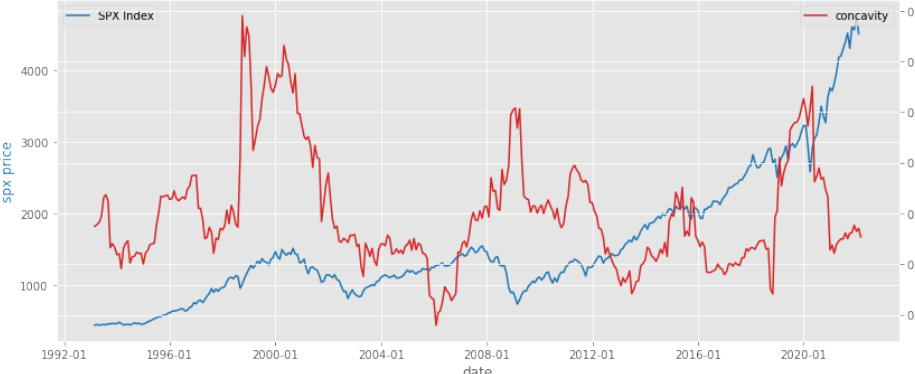
Figure 2. Concavity vs. S&P 500 Index (monthly).